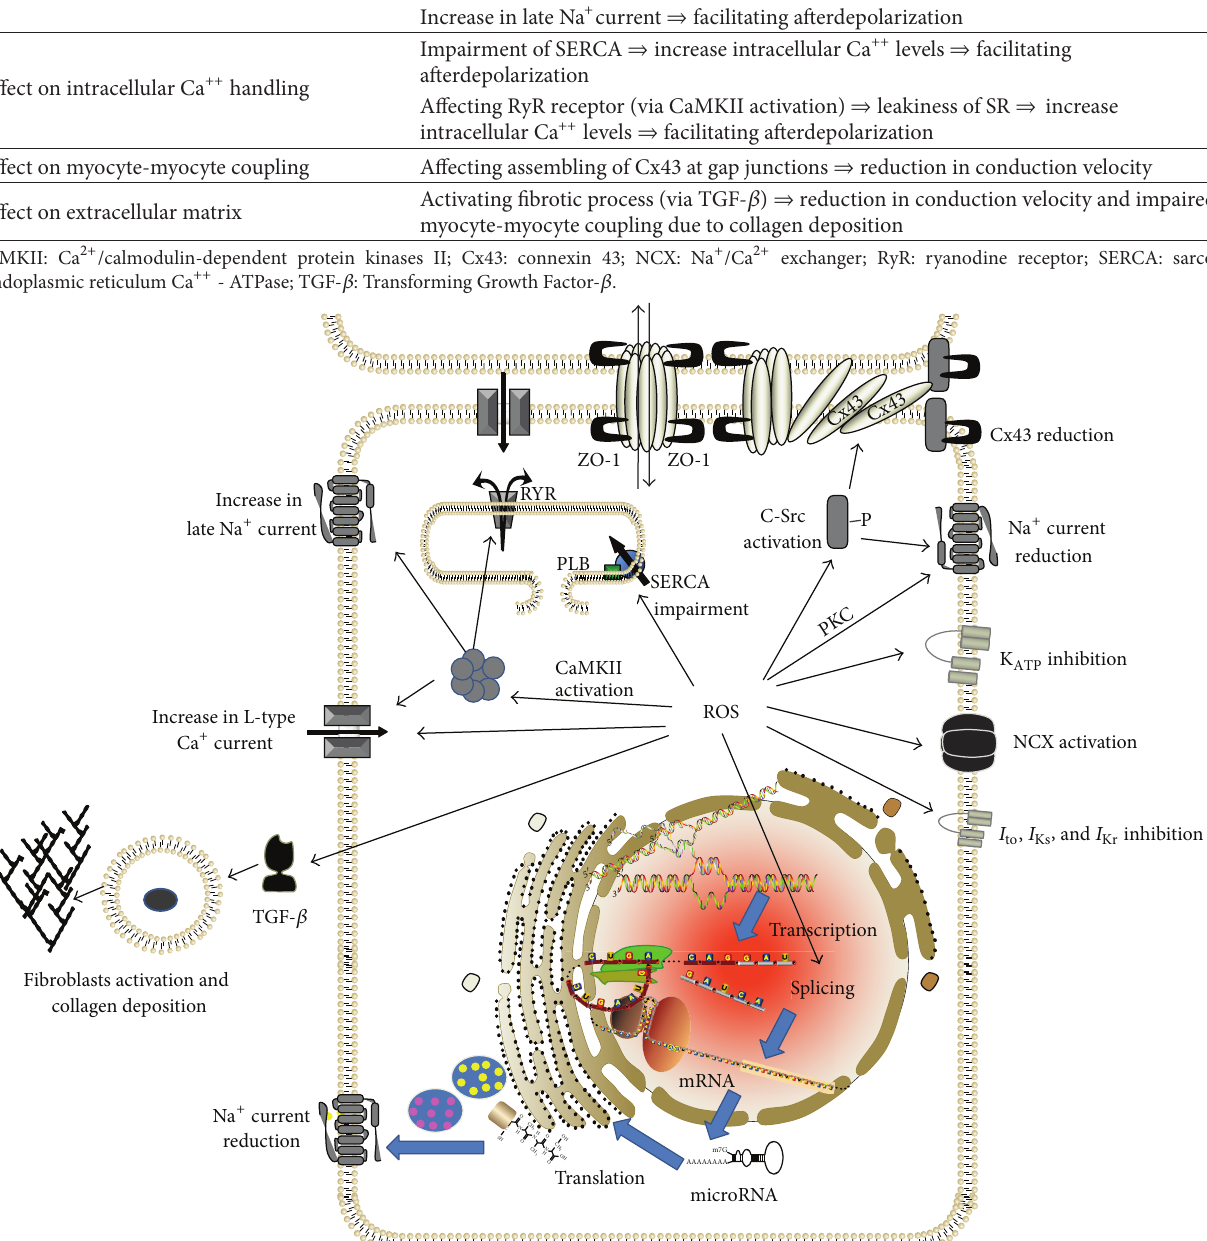
Figure1:SchematicreviewofsomeoftheimportantknownmechanismsbywhichexcessROSmayinducearrhythmia.ActivationofCaMKII, c-Src, and PKC may mediate several important effects of ROS on ionic currents resulting in arrhythmia. In addition, ROS adversely affect splicing of mRNA of cardiac sodium channels resulting in abnormal truncated cardiac sodium channel proteins and a reduction in normal sodium channels. ROS also increase fibrosis and impair gap junction conduction, resulting in reduced myocyte coupling. Abnormal splicing, activation of CaMKII, c-Src, and PKC are among emerging new antiarrhythmic therapeutic targets. CaMKII: Ca 2+ /calmodulin-dependent protein kinases II; CX43: connexin 43; NCX: Na + /Ca 2+ exchanger; PLB: phospholamban; ROS: reactive oxygen species; RYR: